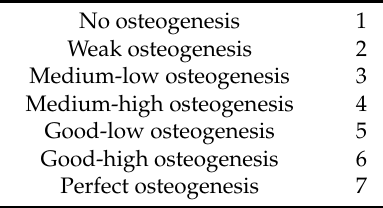
Table 3. Histological scoring table for bone healing used for statistical